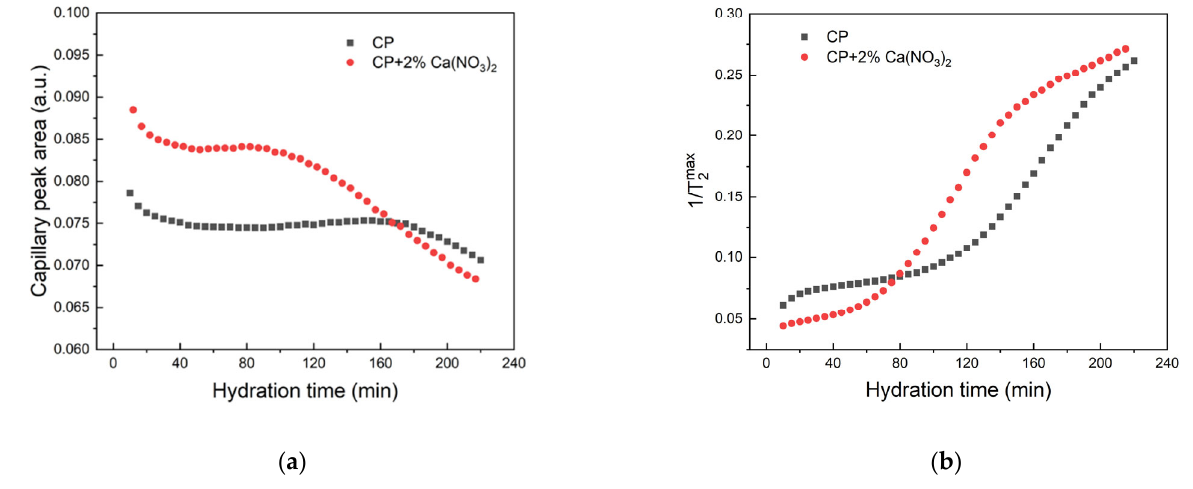
Figure 2. ( a ) Capillary peak area versus hydration time for the two cement pastes. ( b ) Relaxation rates corresponding to the maximum of the capillary versus hydration time.